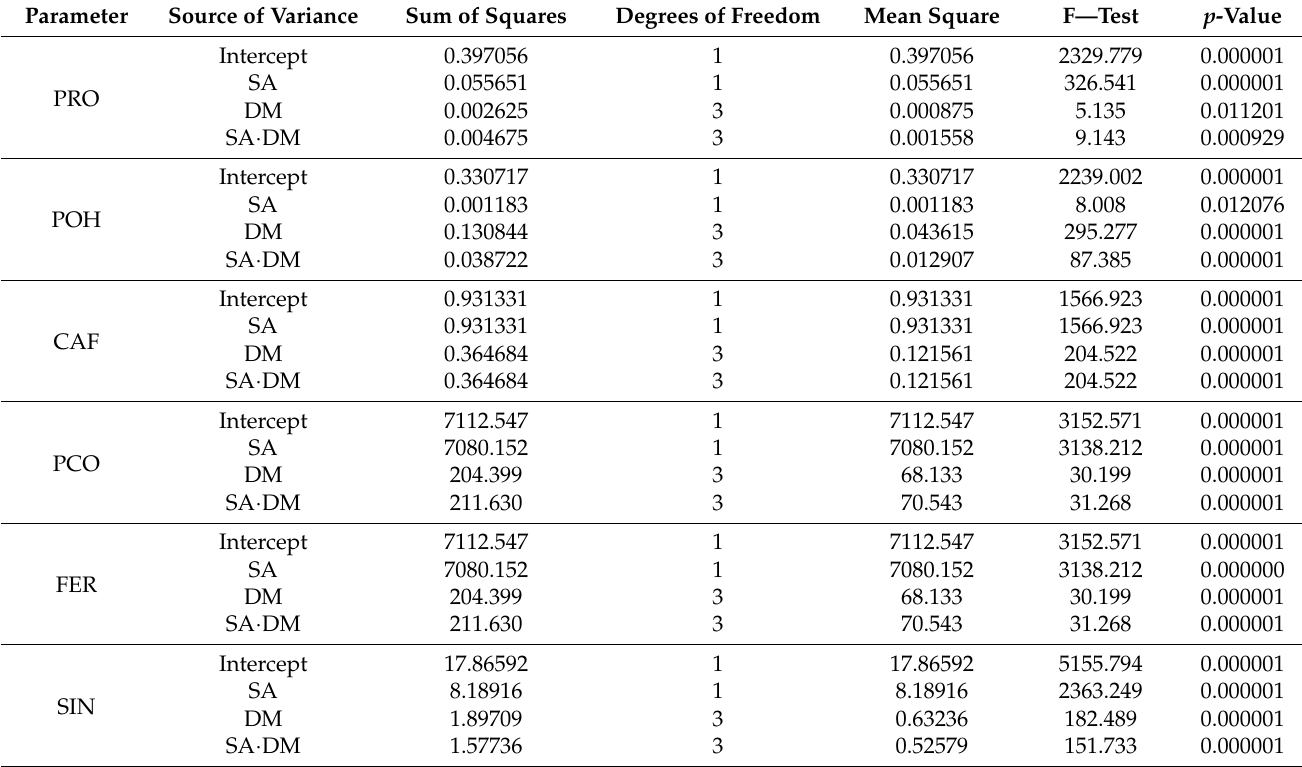
Table 7. The analysis of variance for parameters characterizing the phenolic acids of dried